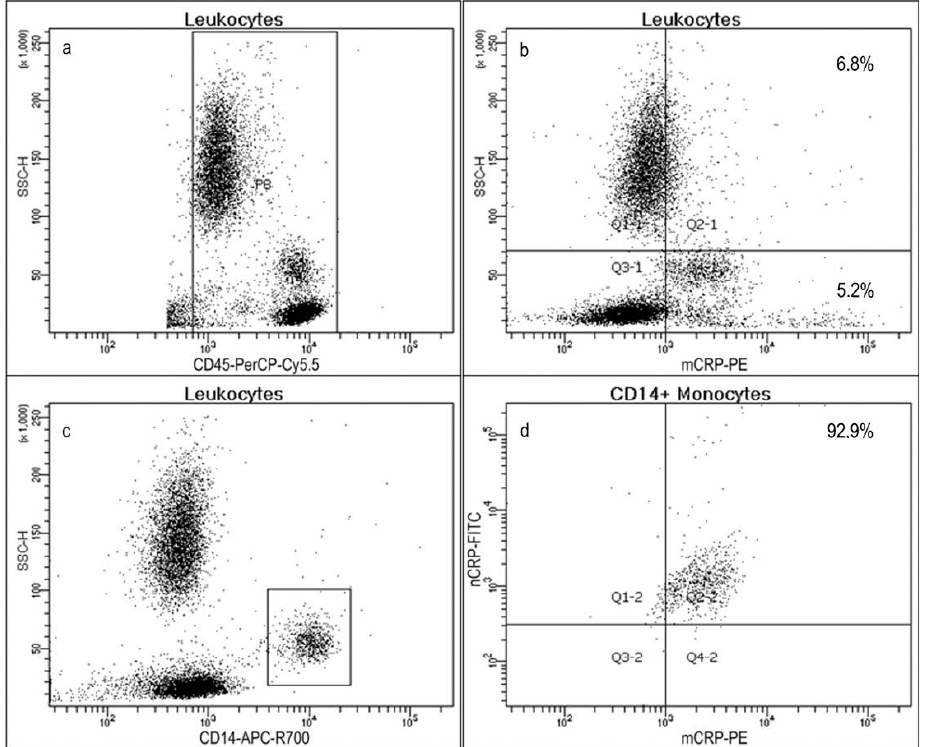
Figure 3. Flow cytometry diagrams of whole blood samples after erythrocyte lysis. ( a ) CD45-positive cells (leukocytes), selected with a rectangular gate; ( b ) mCRP-positive leukocytes; ( c ) CD14-positive leukocytes (monocytes), selected with a rectangular gate; ( d ) mCRP and pCRP-positive monocytes. pCRP—pentameric C-reactive protein; mCRP—monomeric C-reactive protein; SSC-H—side scatter.